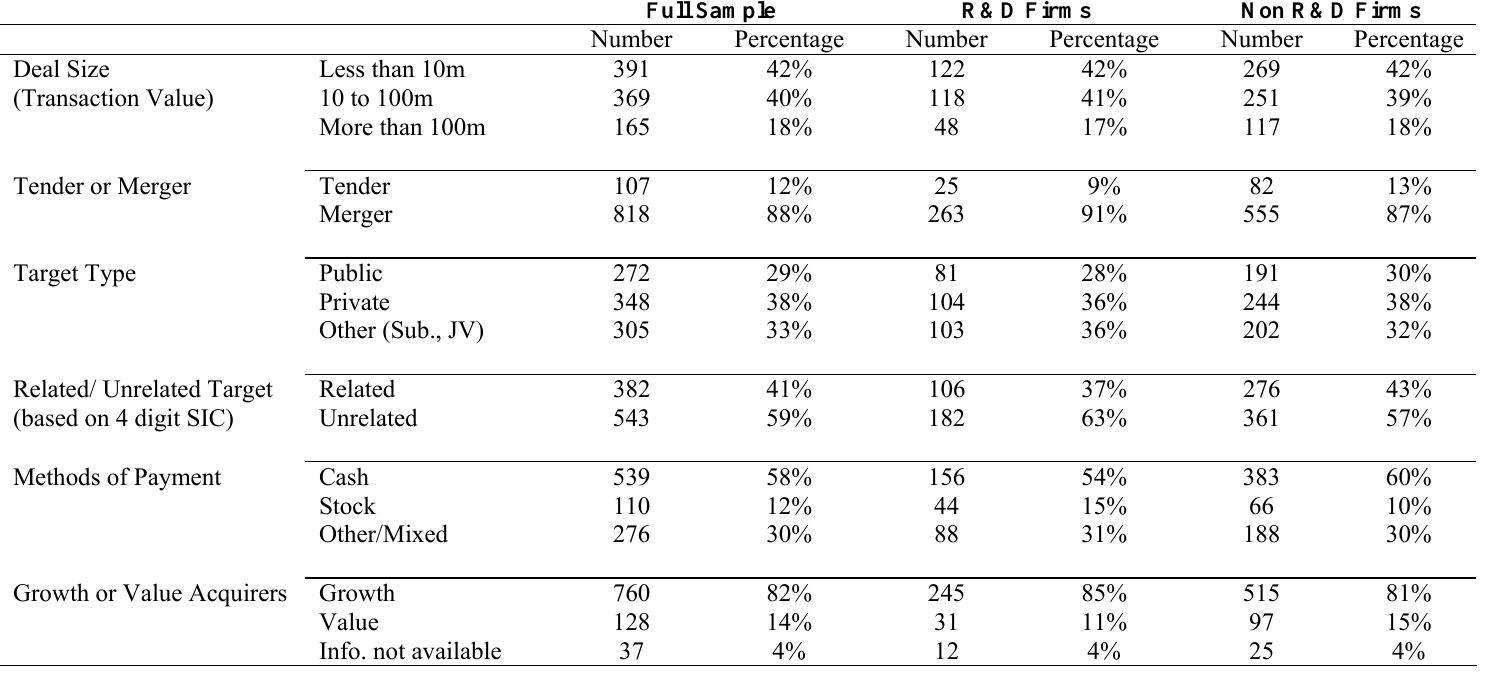
Table 2. Descriptive Statistics of Deal-Specific Variables for Acquiring Firms The sample consists of 925 annual observations for acquiring firms between 1993 and 2002. For acquiring firms, only one event is considered in case of multiple acquisitions by the firm in any year. “Deal size” is the total transaction value in million Canadian dollars. “Tender or merger” is a dummy variable. If